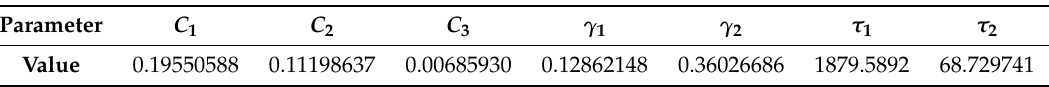
Table 1. Optimised set of material parameters for the Yeoh material model, as well as the relaxation parameters for the two Maxwell